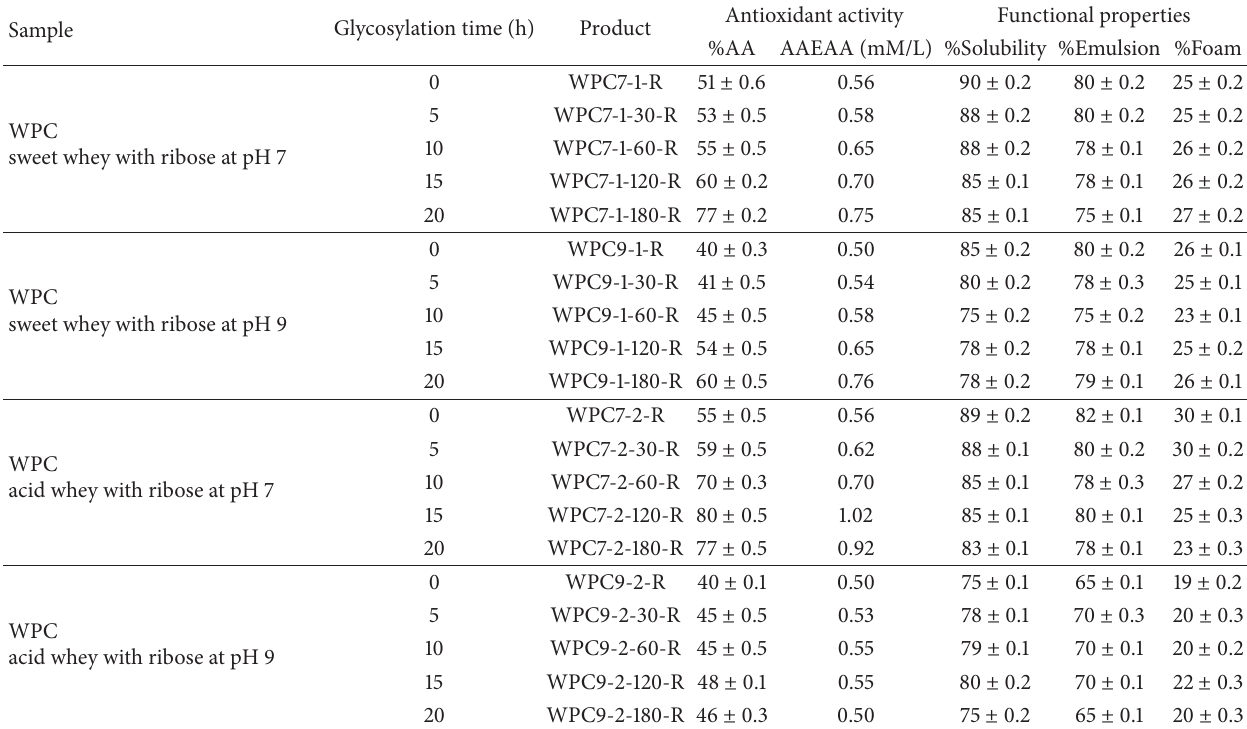
Table 3: Features of glycosylated product from WPC of sweet and acid whey with ribose, heating to 50 ∘ C, pH 7 and pH 9.